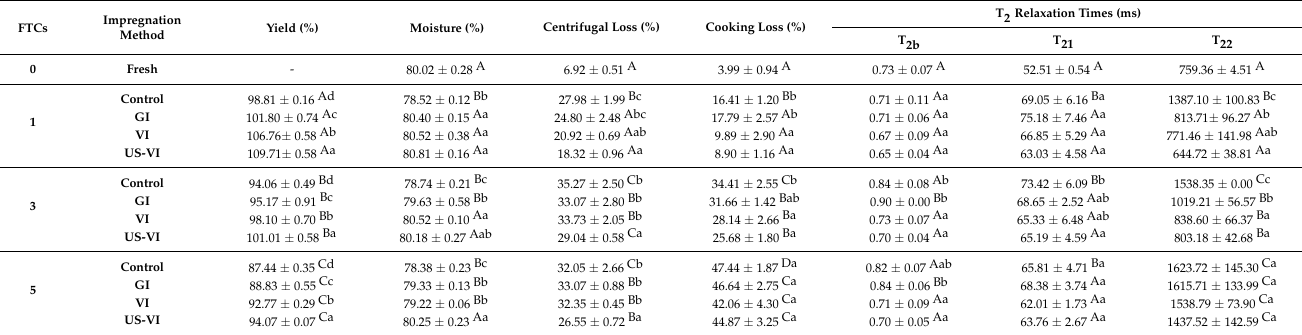
Table 1. Changes in the water-holding capacity of the scallop adductor muscle induced by freeze– thaw cycles.